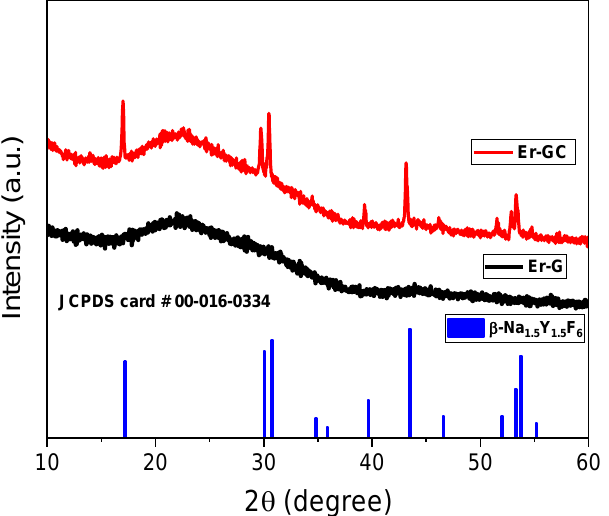
Figure 3. X-ray diffraction patterns of Er-doped oxyfluoride silicate glass (Er-G) and glass-ceramic (Er-GC) heat-treated at 650 °C for 40 h. Table 1. Crystal parameters of the hexagonal sodium ytrium fluoride crystals in Er-GC obtained by Rietveld analysis.